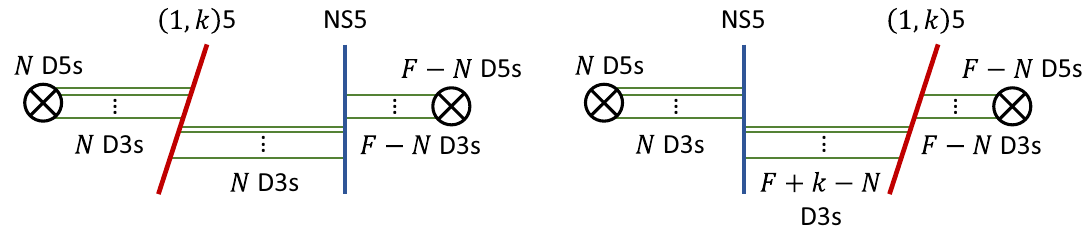
Figure 2 . The brane configurations which correspond to (B.31) (left) and (B.38) (right). These two brane configurations are related with each other via the Hanany-Witten